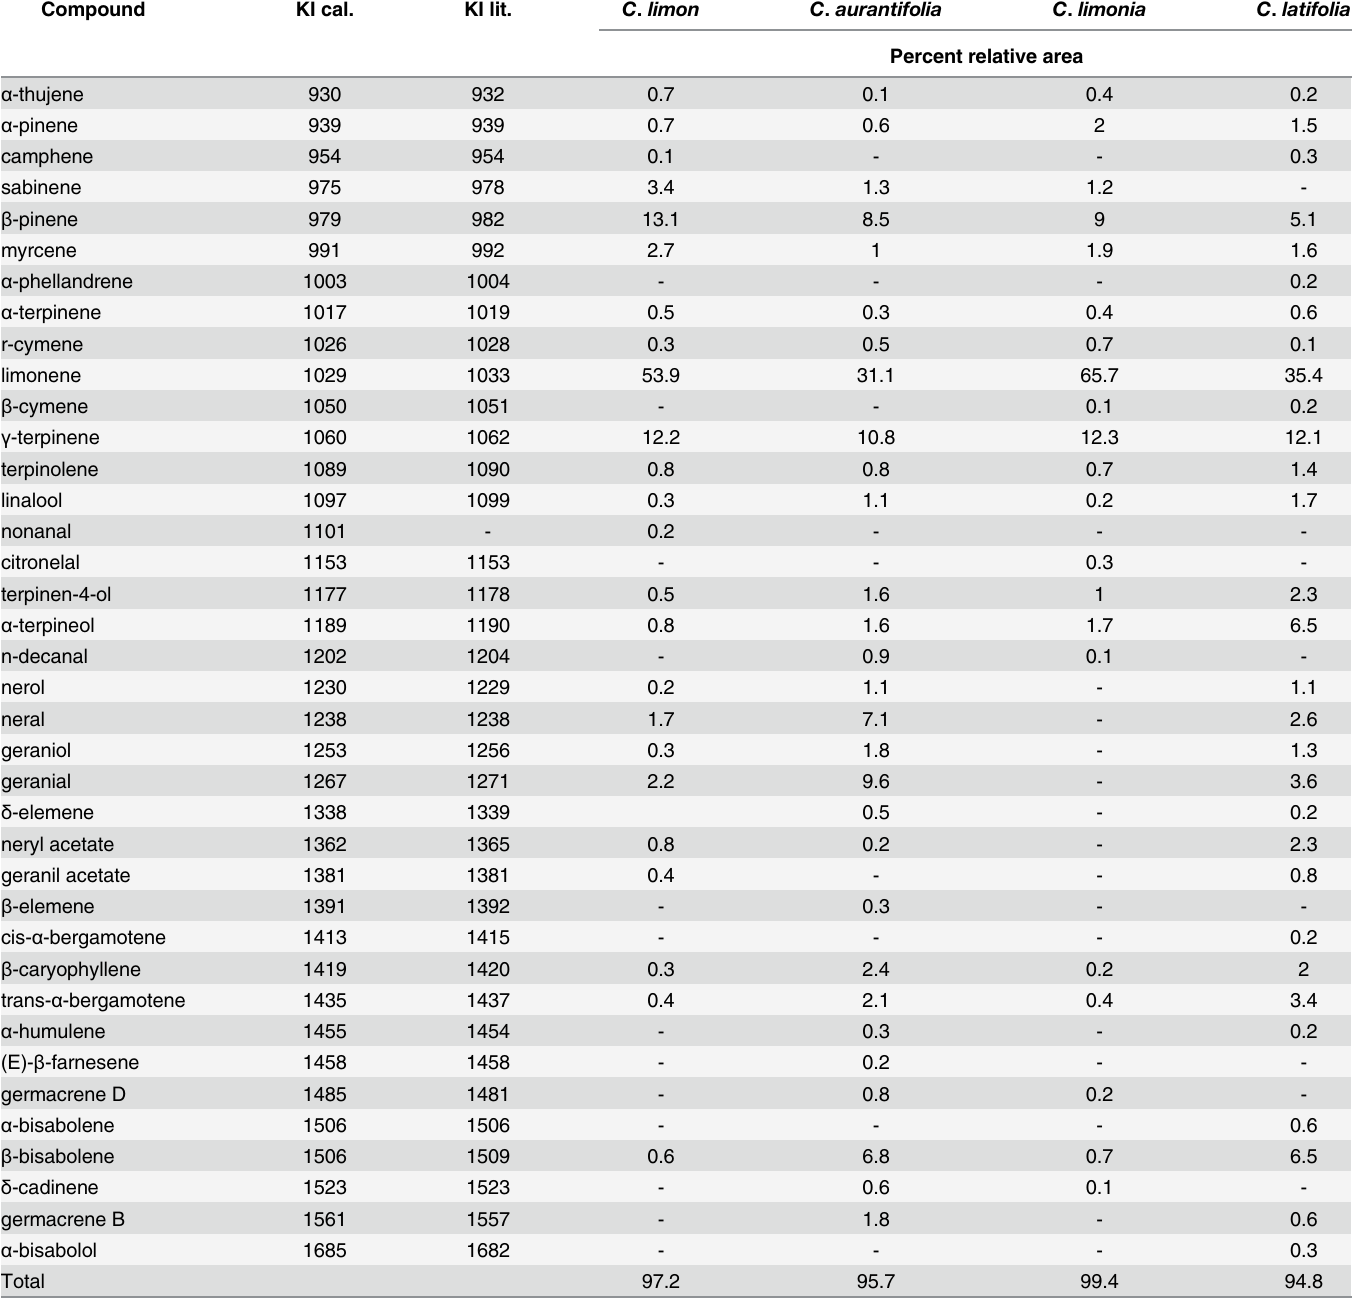
Table 1. Chemical composition of peel essential oils of four Citrus samples. Compound KI